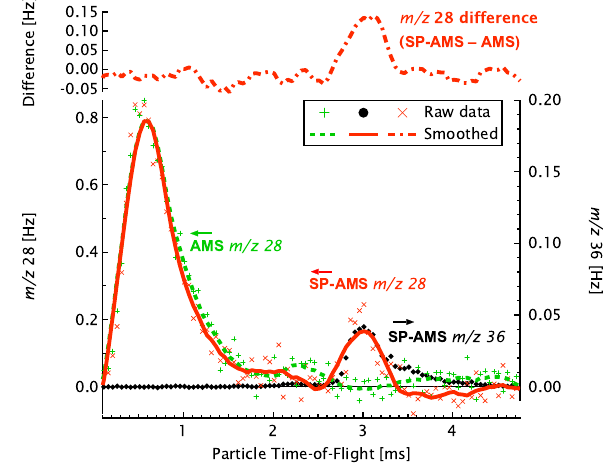
Fig. 6. Signal at m/z 28 (N + or CO + ) and m/z 36 (C + ) as a func- 2 3 tion of particle time-of-flight for polydisperse RB particles. Data symbols show the raw SP-AMS or AMS data, which have been smoothed by a Savitsky–Golay filter for clarity when the signal- to-noise was low (curves). The first peak (0.6ms) corresponds to gas-phase N 2 , the second (3ms) to CO + originating from the RB particles. The upper panel (dash-dotted line) shows the difference of the SP-AMS and AMS